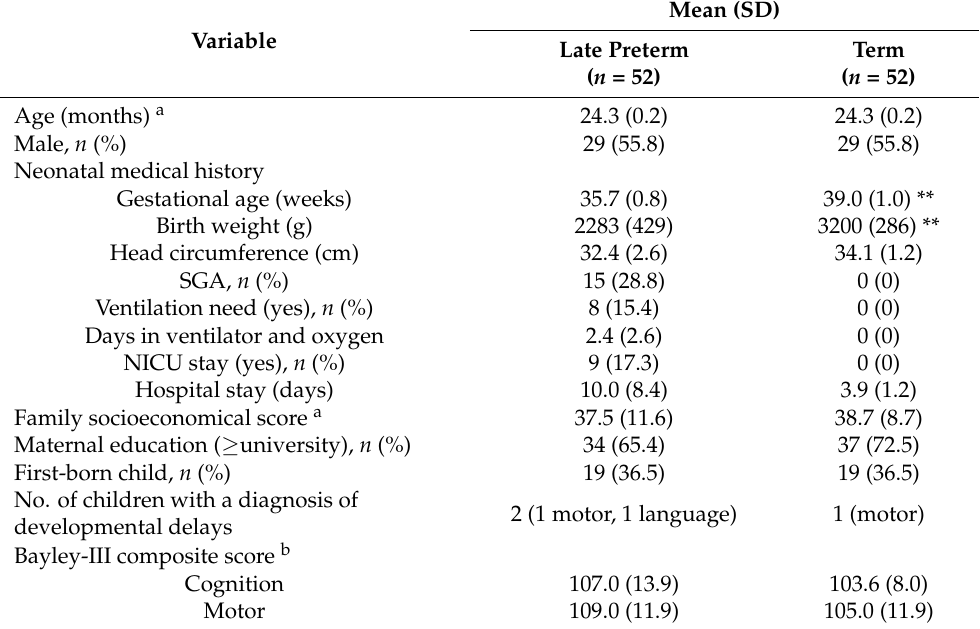
Table 1. The children’s